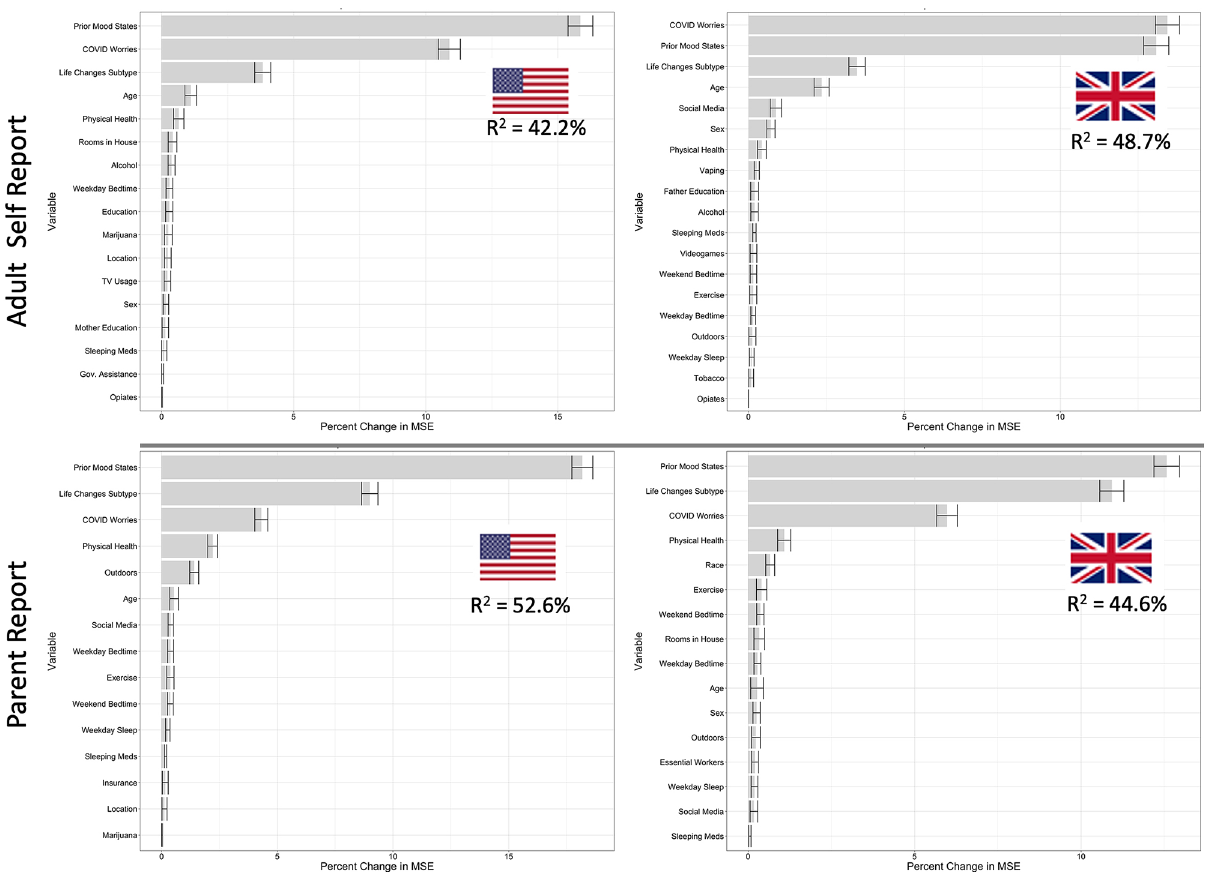
Figure 3. Variable importance and overall performance of Random Forest models predicting Current Mood States in the US and UK in both Adult self-report and parent report data. Variables are ranked by importance as measured by out-of-bag change in mean squared error (MSE), and those with a 95% lower bound above zero are shown here. Variables included: Prior Mood States, Life Changes Subtype, COVID Worries, physical health, age, sex, outdoors, exercise, social media, TV, videogame, weekend bedtime, weekend sleep, weekday bedtime, weekday sleep, insurance, rooms in house, government assistance, number in household, essential worker in household, Marijuana, Alcohol, vaping, opiates, sleeping medication and other drug